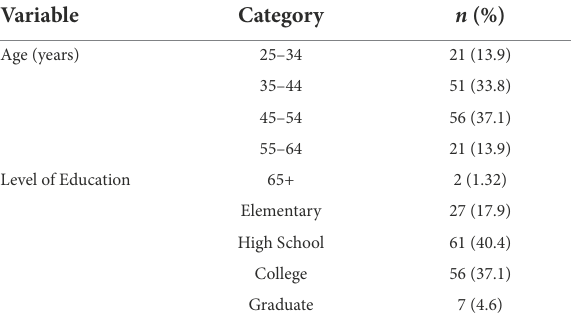
TABLE 1 Frequencies and percentages of the virtual workshop demographics ( N =